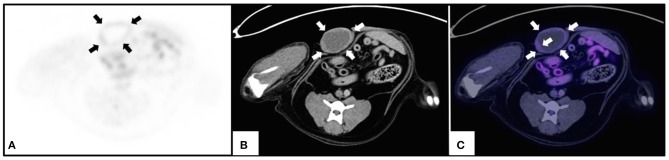
PET/CT of a benign canine mammary gland tumor. An intact female 8-year old, Golden retriever, with a 6.1 cm tumor of longest diameter on the right cranial-abdominal gland which corresponded to a fibroadenoma. The figure shows the same transverse slice by (A) PET; (B) CT, and (C) image fusion. Arrows indicate the periphery of the tumor and the increase in metabolic glucose uptake is shown in purple (C).